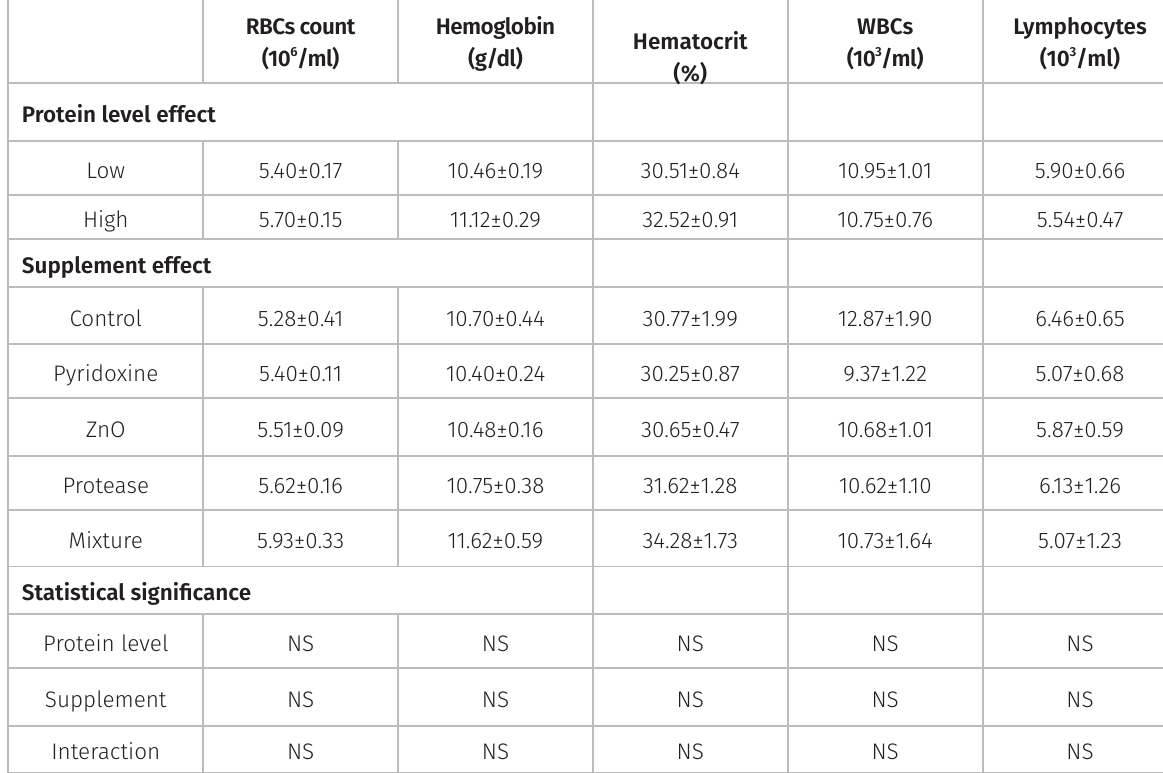
Table VI. Hematological parameters (Mean± SE) of New Zealand White rabbits as affected by protein level and tested feed